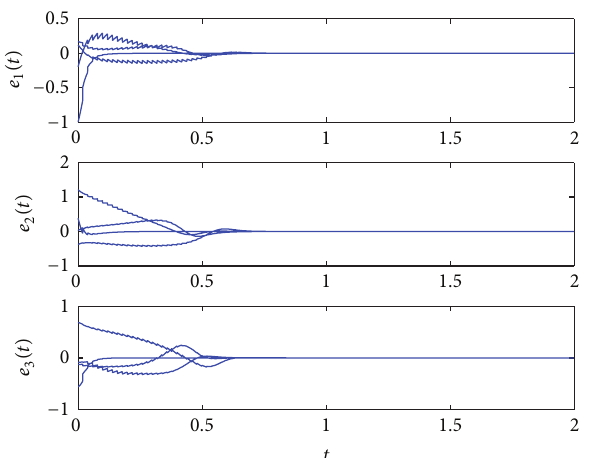
Figure 1: Evolution process of synchronization errors of two Chua’s circuit networks.